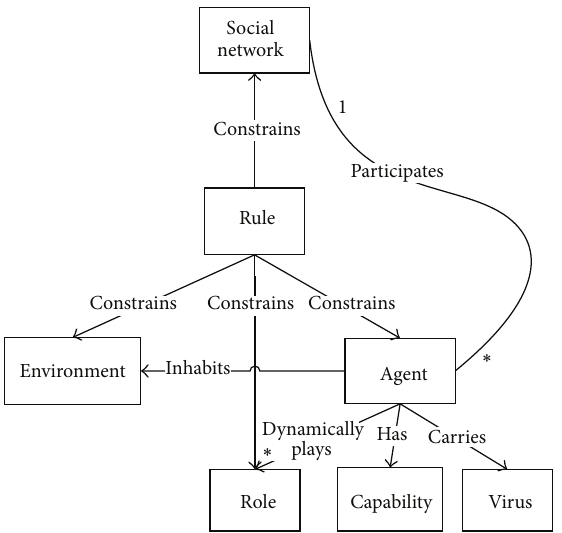
Figure 1: Metamodel of the zombie-city